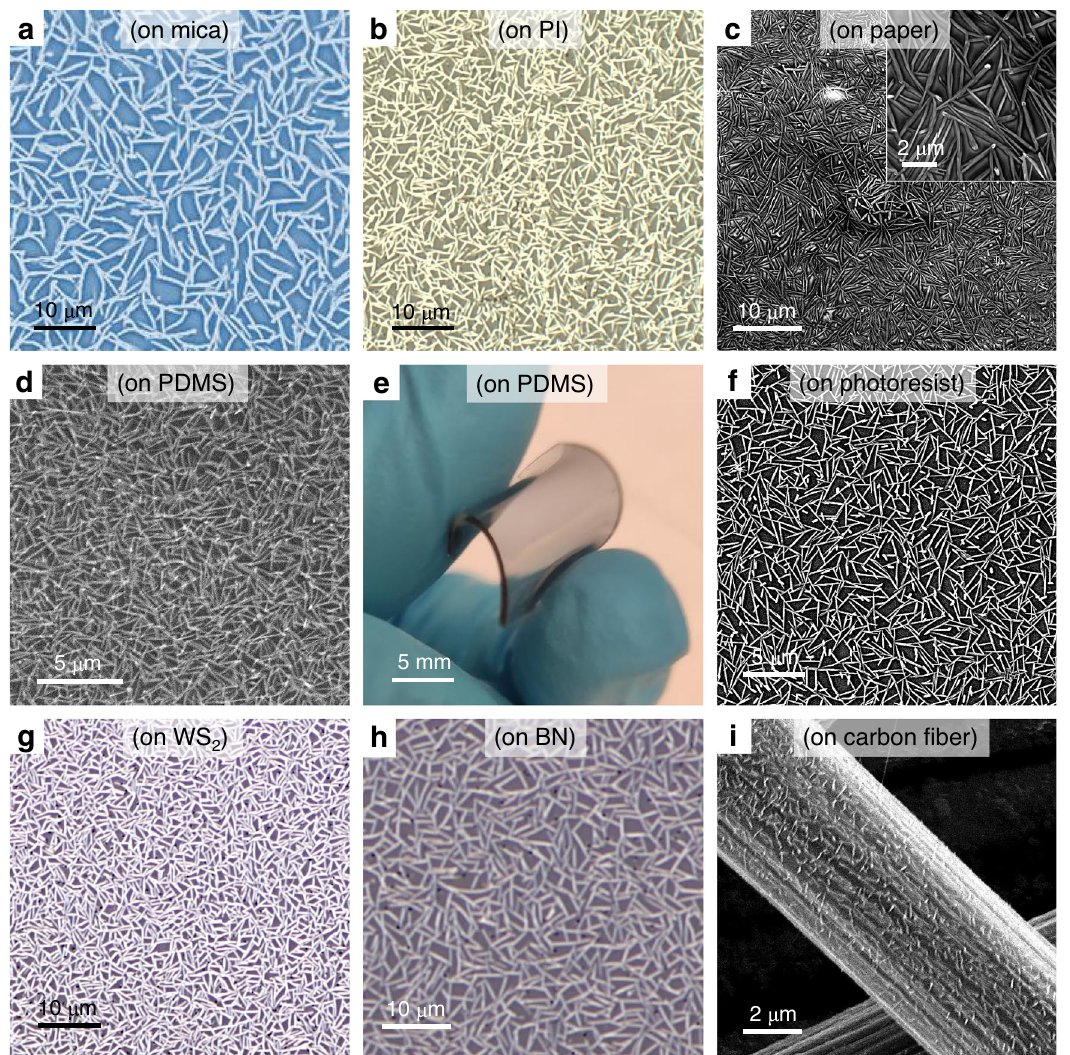
Fig. 4 | Multi-substrate compatible growth. Optical and SEM images of Te nanomesh grown on different surfaces, including a mica (optical), b PI (optical), c paper (SEM), d PDMS (SEM), e PDMS (photograph), f photoresist (SEM), g WS 2